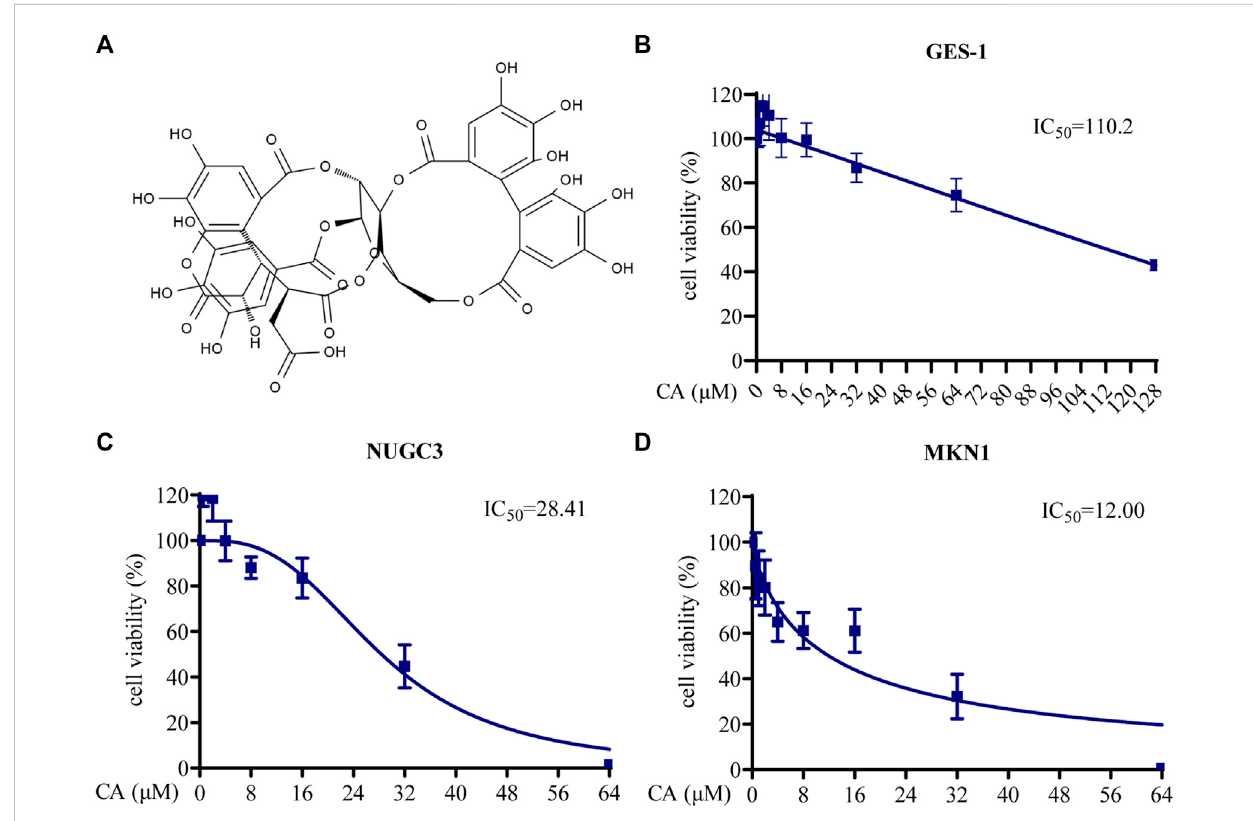
FIGURE 2 ThecytotoxicityofCAinGC cells. (A) ThestructuralformulaofCA. (B) CellviabilityofGES-1cellstreatedwithdifferentconcentrationsofCA. (C) Cell viability of NUGC3 cells treated with different concentrations of CA. (D) Cell viability of MKN1 cells treated with different concentrations of